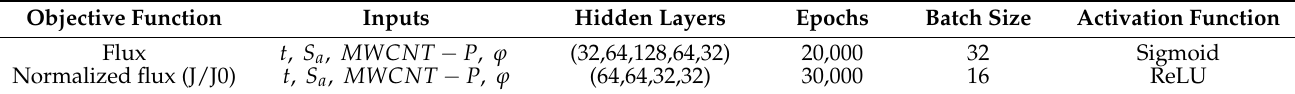
Table 6. The proposed models for the output